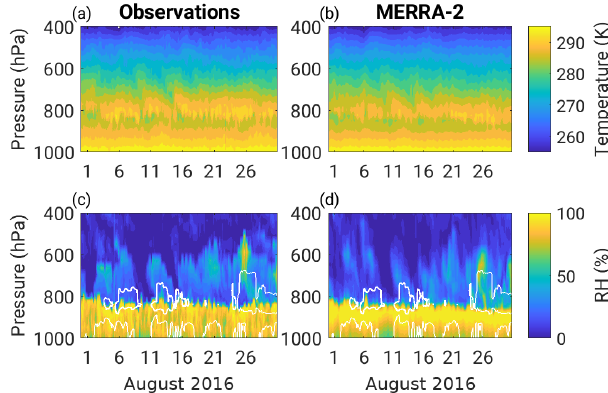
Figure 6. Hourly vertical profiles of (a, b) temperature and (c, d) relative humidity over Ascension Island from the INTERP- SONDE observations and MERRA-2 during August 2016. White contours in (c) and (d) indicate an AOD of 0.01 at 1µm.